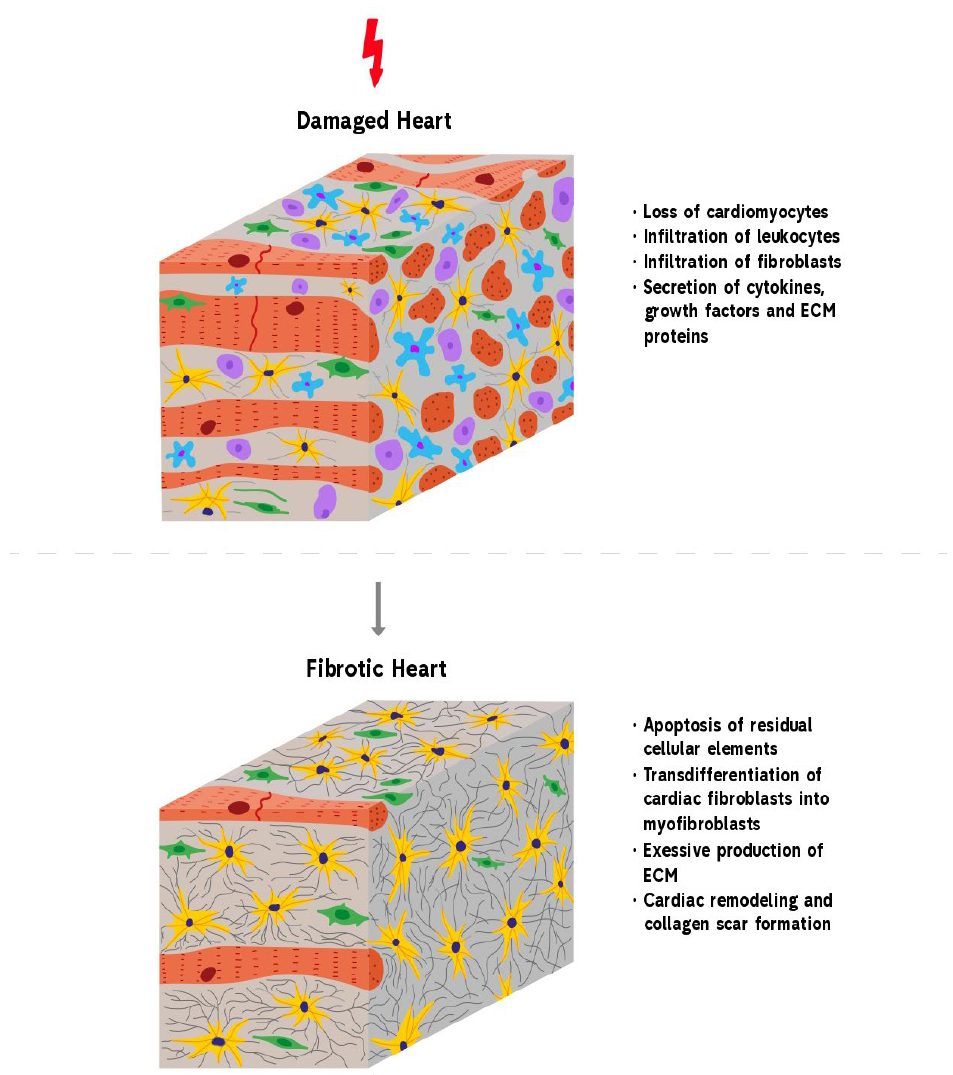
Figure 1. Development of reparative fibrosis in the heart. A healthy heart contains cardiomyocytes that are mainly involved in the contractile function of the heart. An injury to the heart results in myocardial damage. This activates repair mechanisms, leading to the formation of fibrosis. Heart trauma causes the death of cardiomyocytes that express DAMP molecules and by this induce the infiltration of leukocytes and fibroblasts into the damaged area. At the same time, cardiac fibroblasts begin to trans-differentiate into pathological myofibroblasts which, in turn, begin the over-production of ECM proteins. When the wound is cleared from phagocytosing dead cells and matrix debris, resident cells undergo apoptosis and the collagen-based scar is formed.